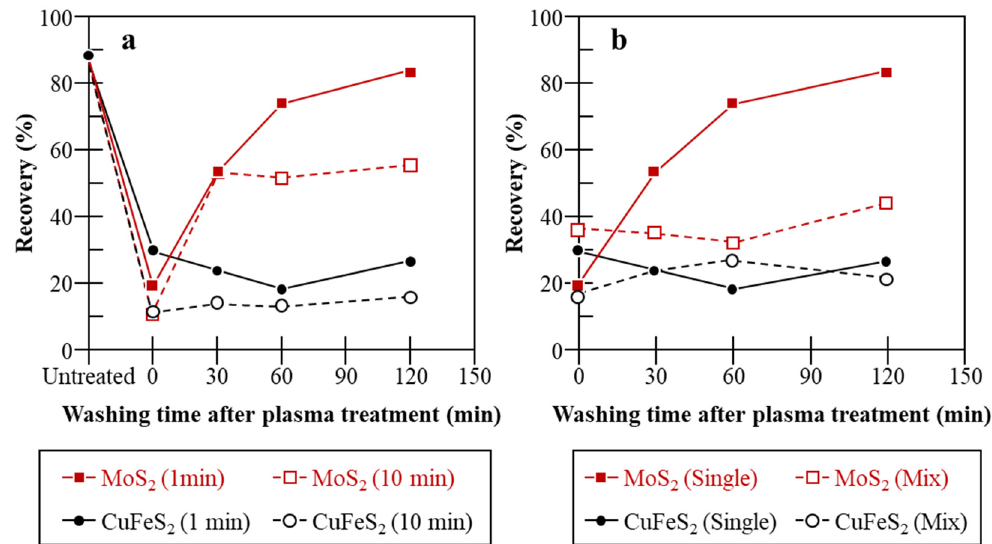
Figure 13. Flotation recovery of chalcopyrite and molybdenite treated ( a ) with and without 10 W plasma for 1 or 10 min followed by washing (single system), and ( b ) with 10 W plasma for 1 min followed by washing (single and mixed system) (reprinted with permission from Hirajima et al. [74], copyright (2014) Elsevier).